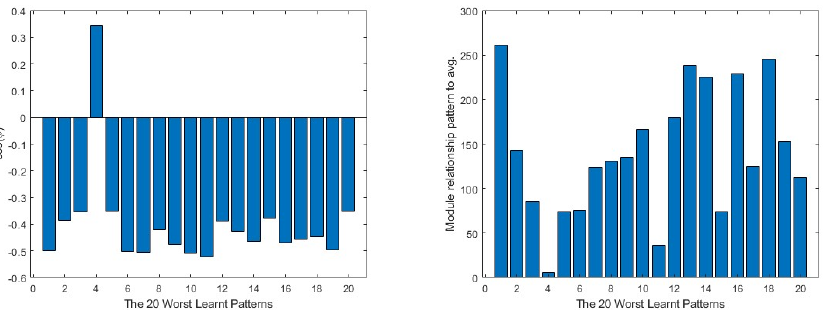
(cid:12) (cid:12) ∂ Loss µ (cid:12) (cid:12) (cid:3339) (cid:4698) relationship to the av- (cid:12) (cid:12) relationship to the ∂ W n (cid:3105)(cid:3024) (cid:3289)